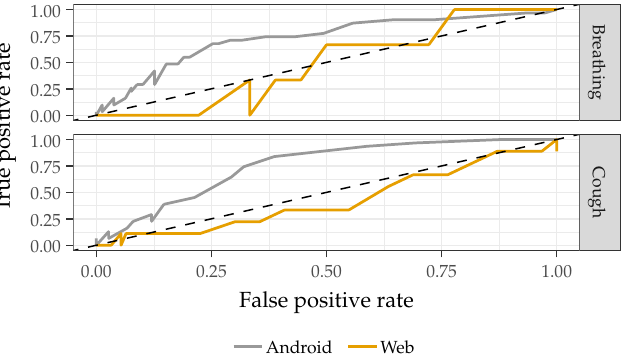
Figure 4. ROC curves comparing the system’s performance using recordings from Android and web- based devices. The system displays decreased performance with recordings from web-based